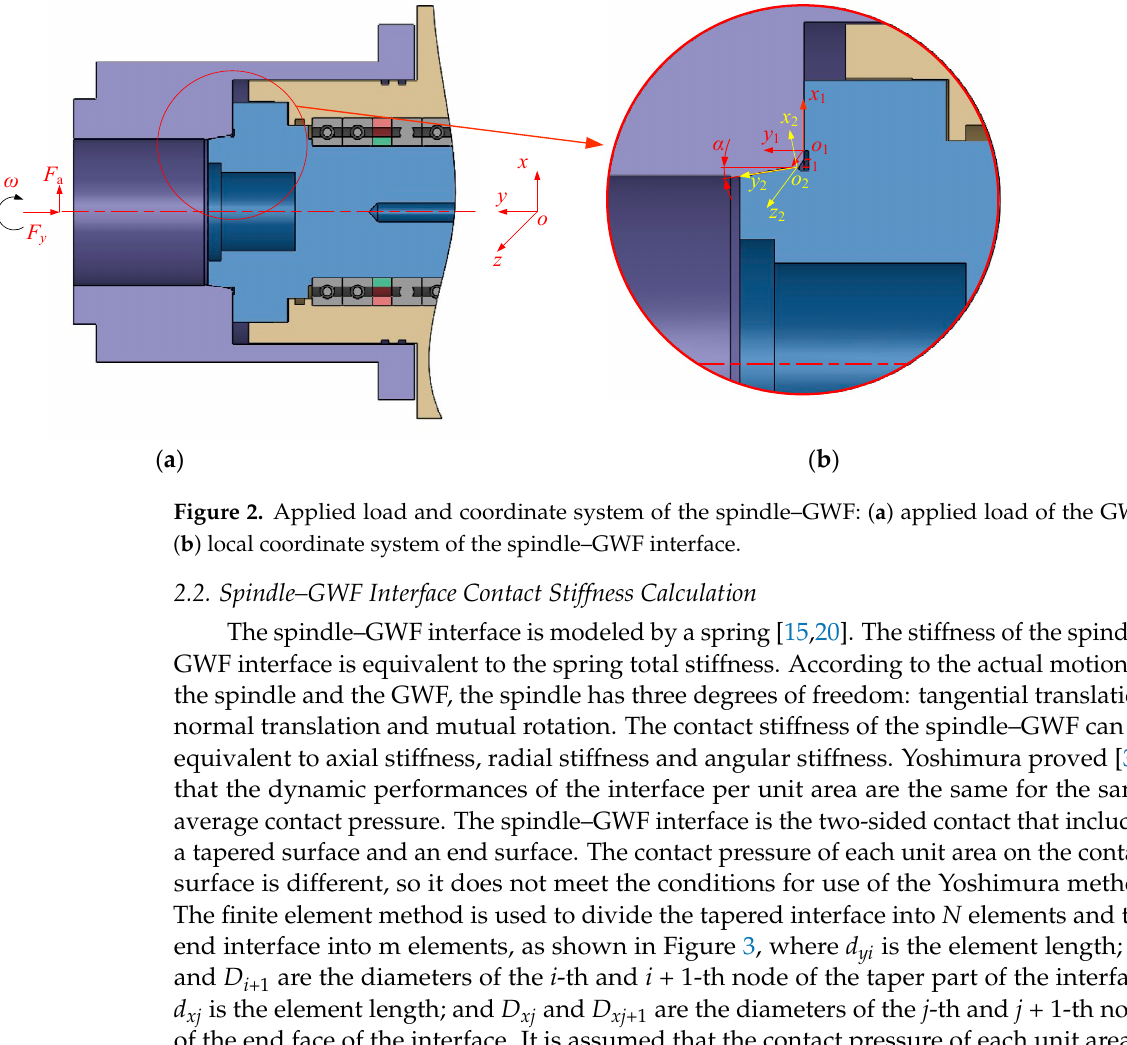
Figure 1. Schematic of the worm grinding-wheel assembly.